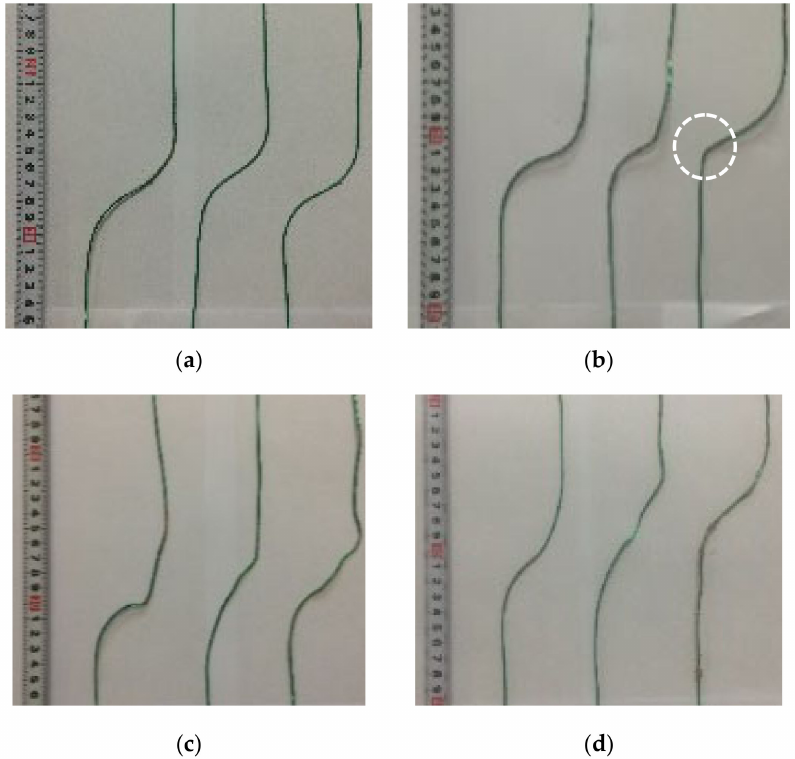
Figure 10. Deformation characteristics of Al wires in samples of group L1 with a vertical pressure of 400 kPa and di ff erent stone contents. ( a ) Stone content 0%; ( b ) stone content 30%; ( c ) stone content 50%; ( d ) stone content 70%.